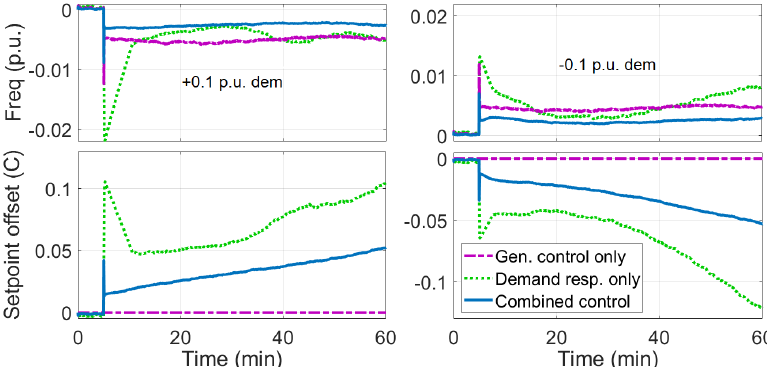
Figure 10. TCL-based transactive frequency control simulation for ±10% step change in load: 10% load increase ( left ), and 10% load cut ( right ).